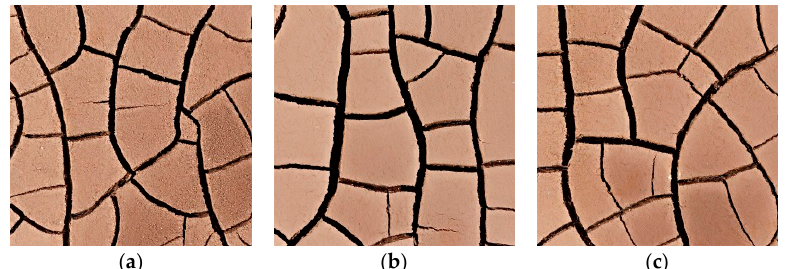
Figure 7. Soil-like fissure development morphology. ( a ) Group S7 specimens; ( b ) Group S8 specimens; ( c ) Group S9 specimens.